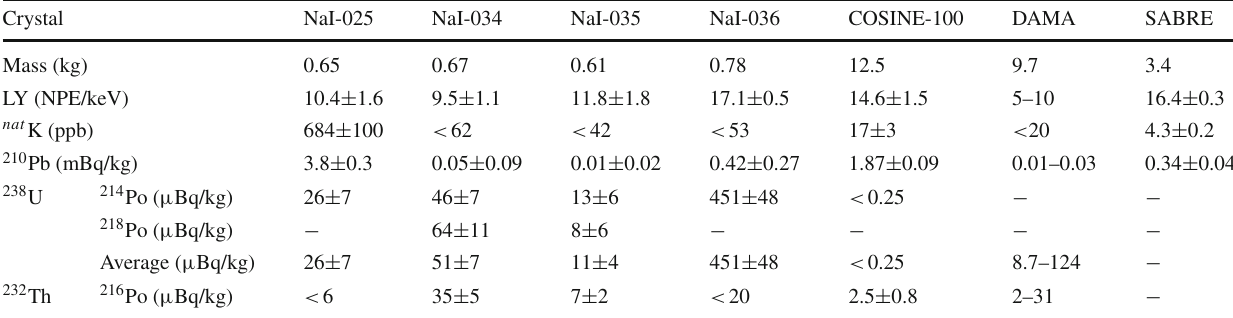
Table 3 Measured results of detector masses, light yield (LY), and the internal contaminations from this study compared with C6 of COSINE-100 [35], DAMA crystals [49,50], and SABRE result [30]